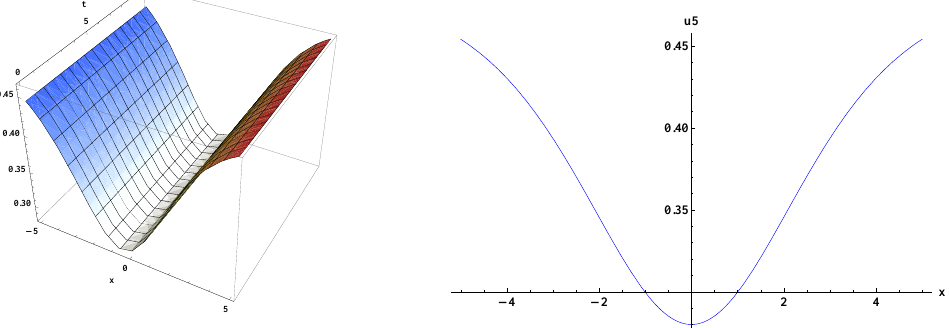
0.4, c = 0.2, 0.4, c = 0.2, − − 0.4, c = 0.2, −